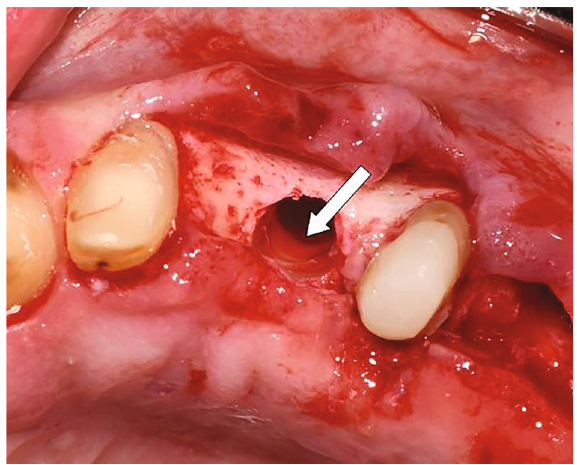
Figure 7: Drill hole through the bone and the impacted tooth (the white